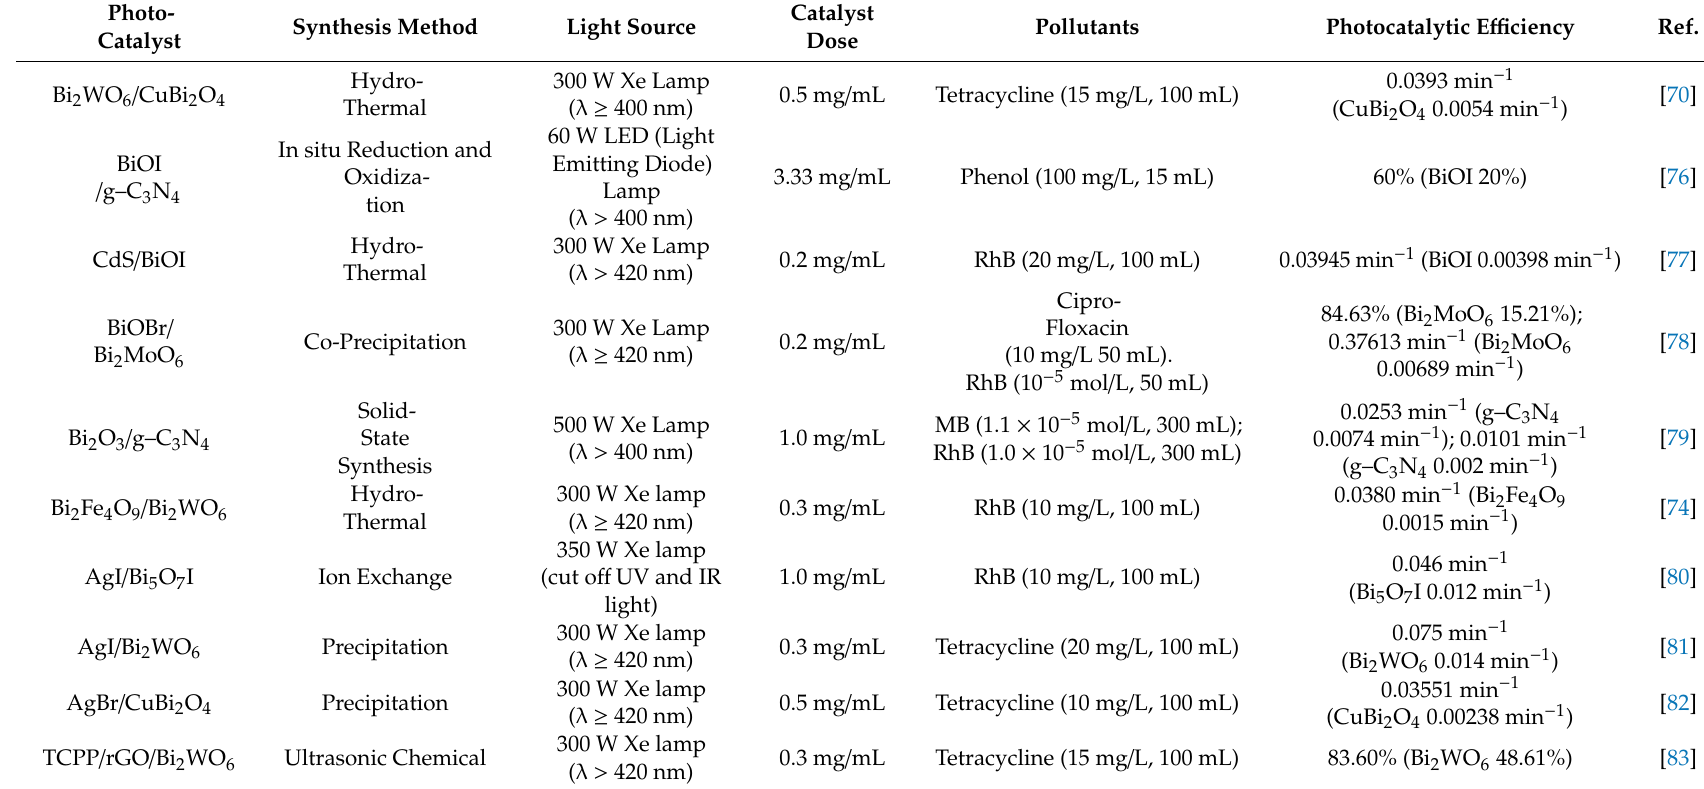
Table 2. Research progress on Bi-based Z-Scheme photocatalysts applied in photocatalytic